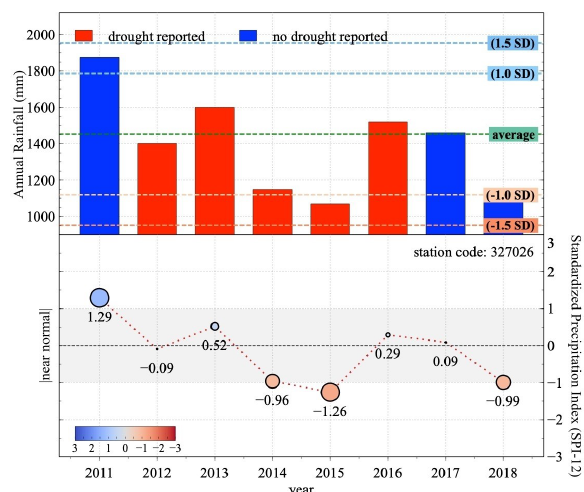
Fig. 8. Interpretation of SPI12 as drought indicator with the amount of annual rainfall and drought information at station Doi Chiang Dao (32706).